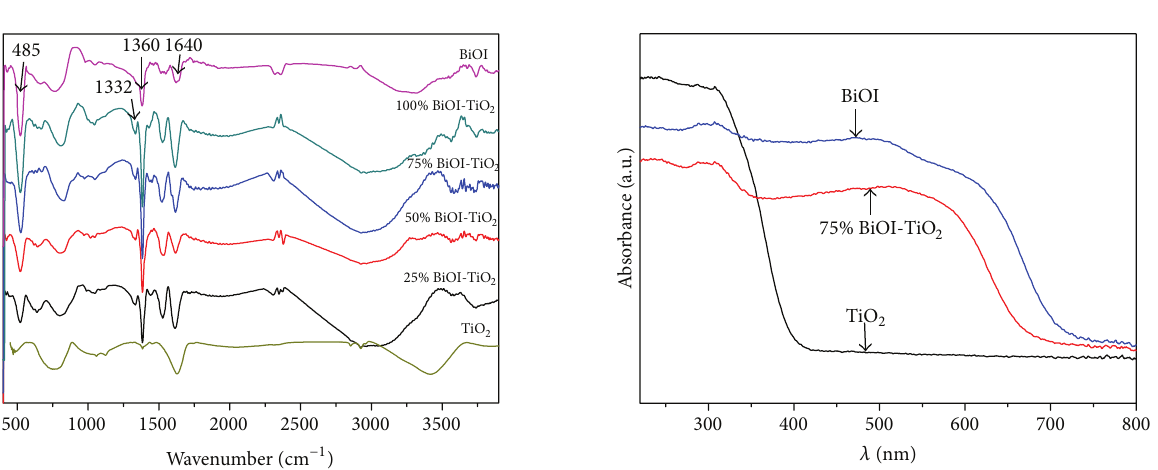
Figure 3: FT-IR spectra of pure TiO 2 , BiOI, and as-prepared BiOI- TiO 2 nanoparticles.